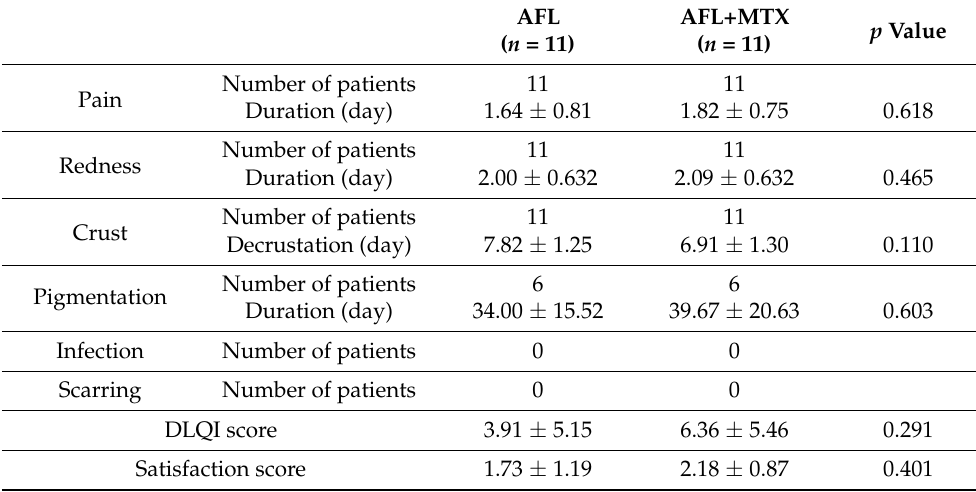
Table 5. Adverse events, DLQI and satisfaction scores of the two treatment groups. AFL group was treated by ablative fractional laser and AFL+MTX group was treated by ablative fractional laser-assisted delivery of